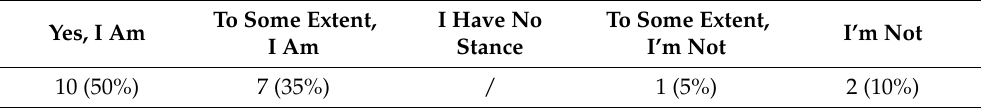
Table 3. Analysis of the answers given to the third question: Please express position and confidence in a given opinion based on observation of a Figure 13b.